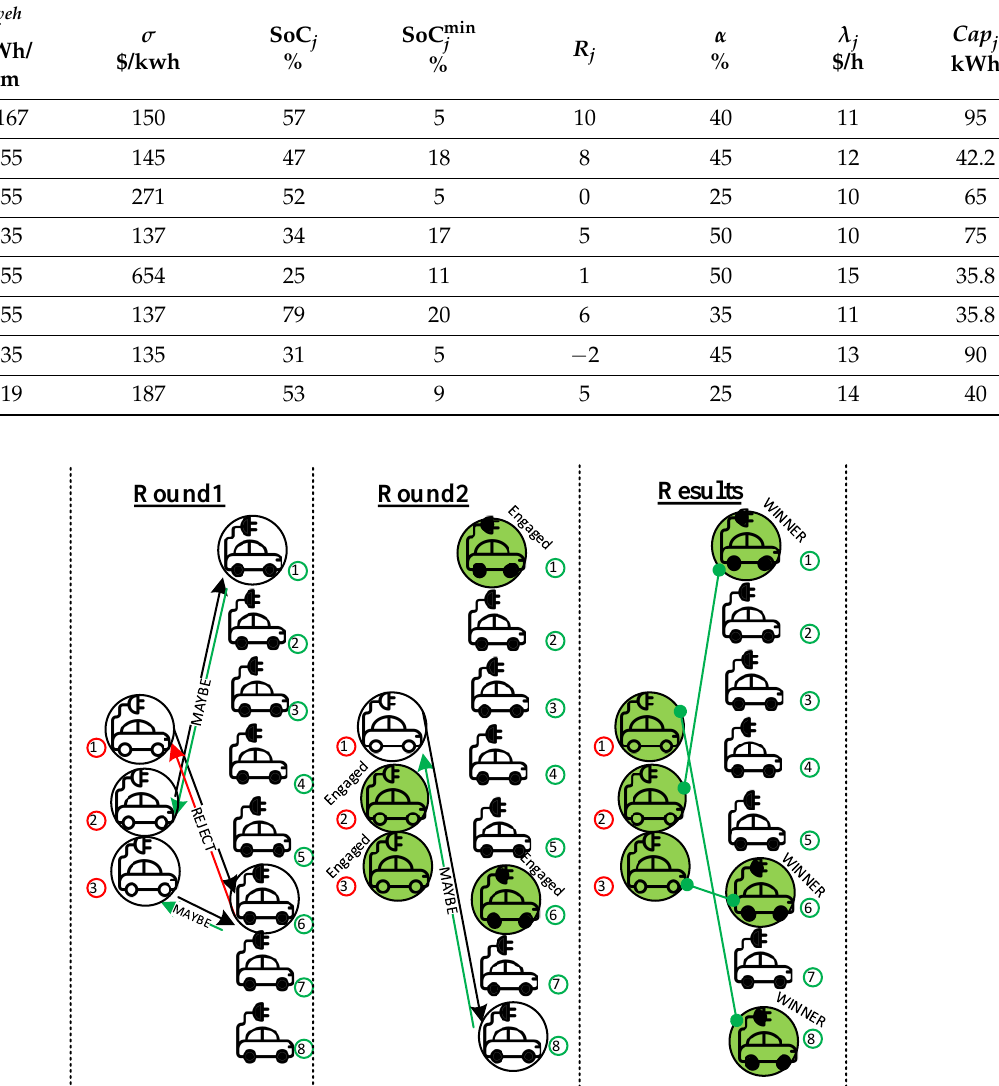
Figure 5. Heatmap and scatter plots of consumers benefits from trade with various providers.